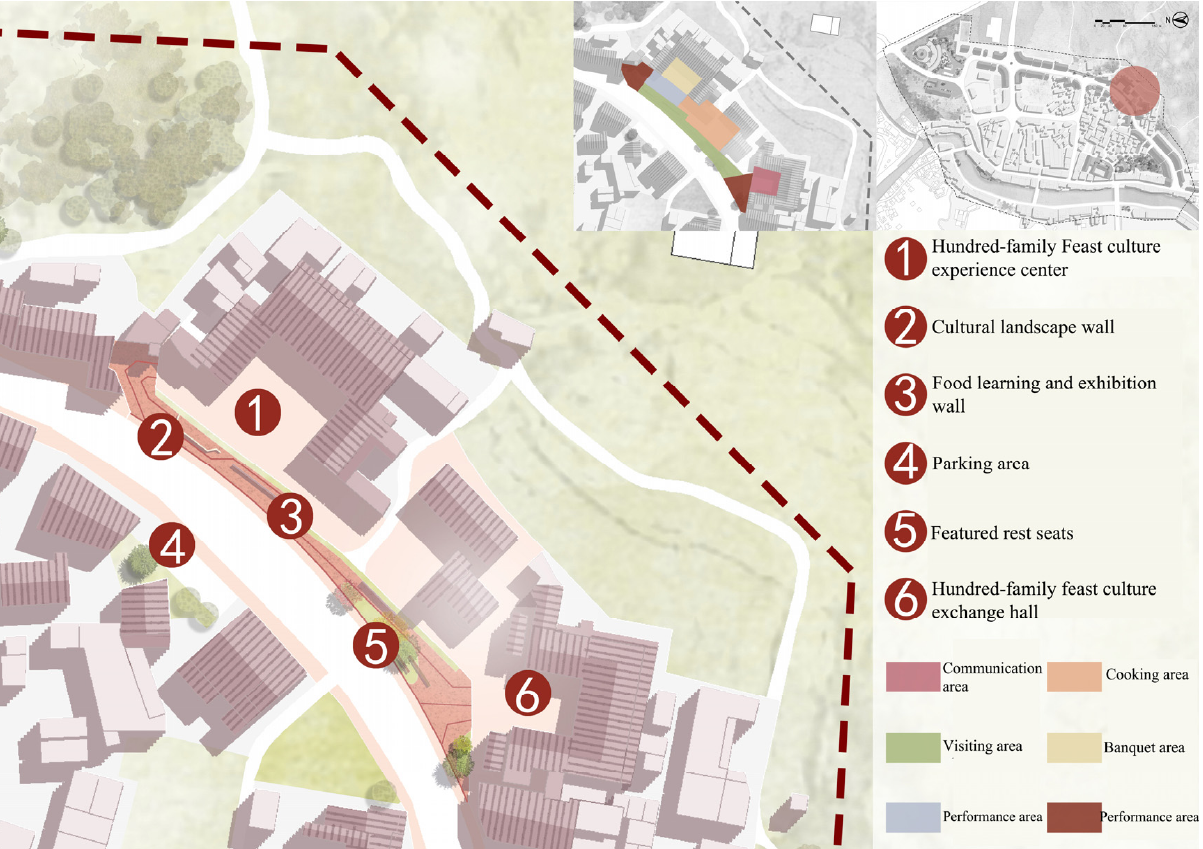
Figure 9. Plan of food culture experience zone landscape.